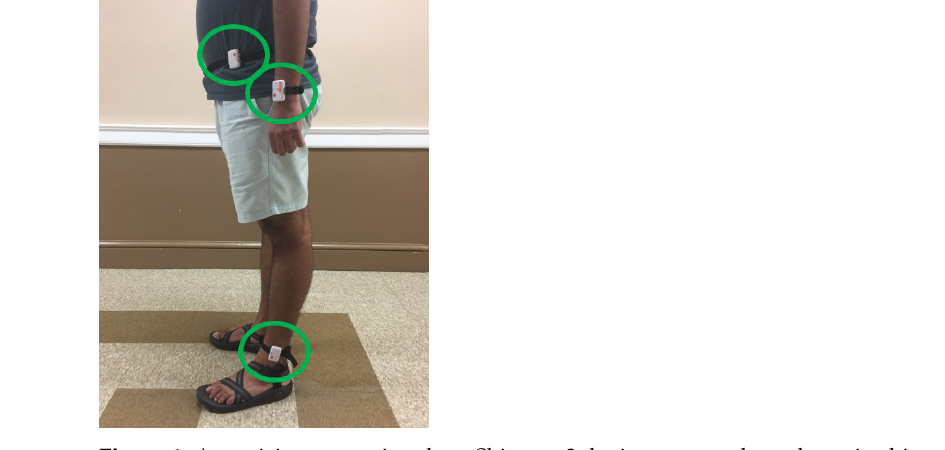
Figure 1. A participant wearing three Shimmer3 devices, one each on the wrist, hip and ankle.